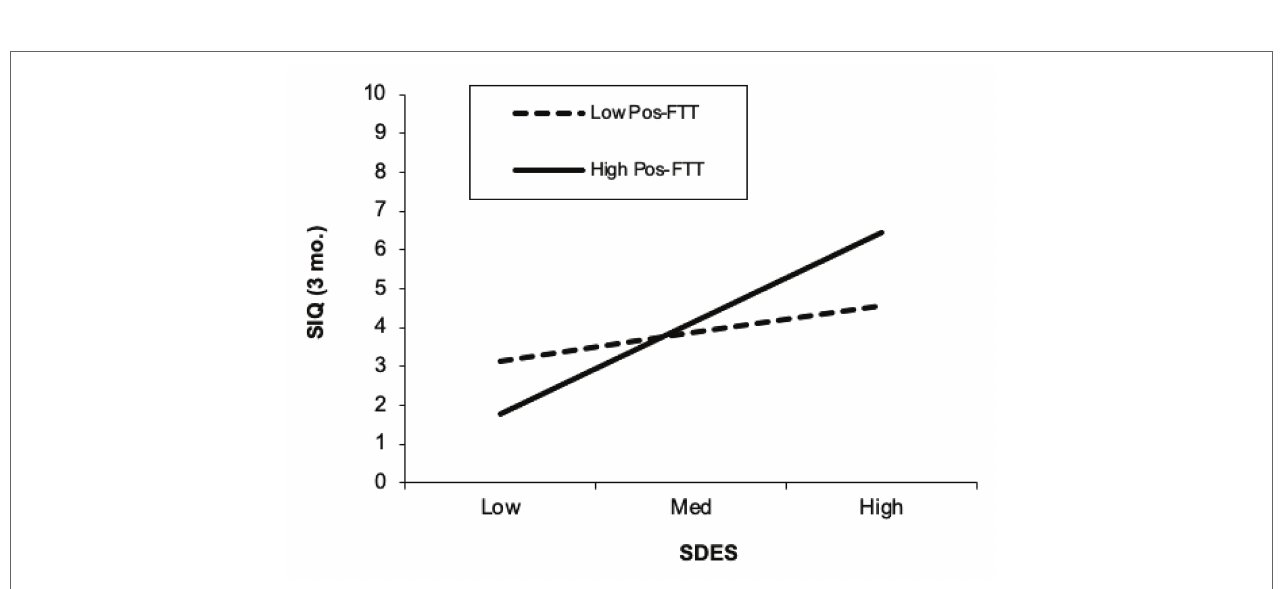
FIGURE 2 | Positive future thinking moderates the association between defeat/entrapment and future (3-month) suicidal ideation. SDES, Short Defeat and Entrapment Scale; SIQ, Suicide Ideation Questionnaire. Greater and lower levels of positive future thinking were defined as + 1 SD and − 1 SD, respectively. The SIQ scale reflects values of the transformed variable, and not raw